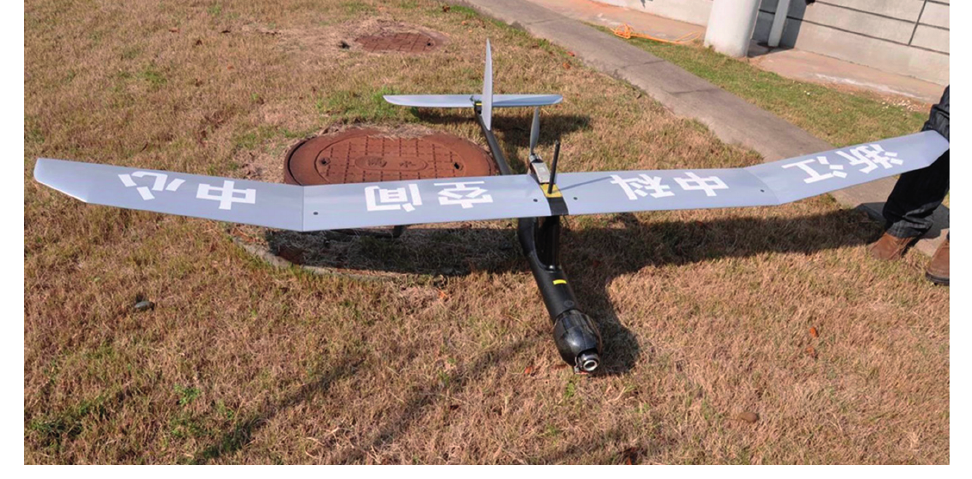
Figure 2. River-Map